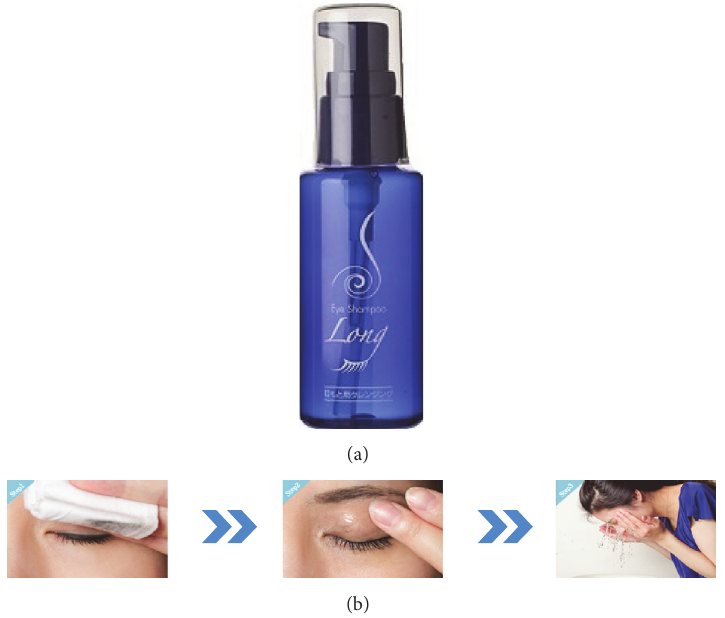
Figure 1: Lid hygiene technique. (a) ESL. (b) Lid cleansing using ESL. ESL: Eye Shampoo